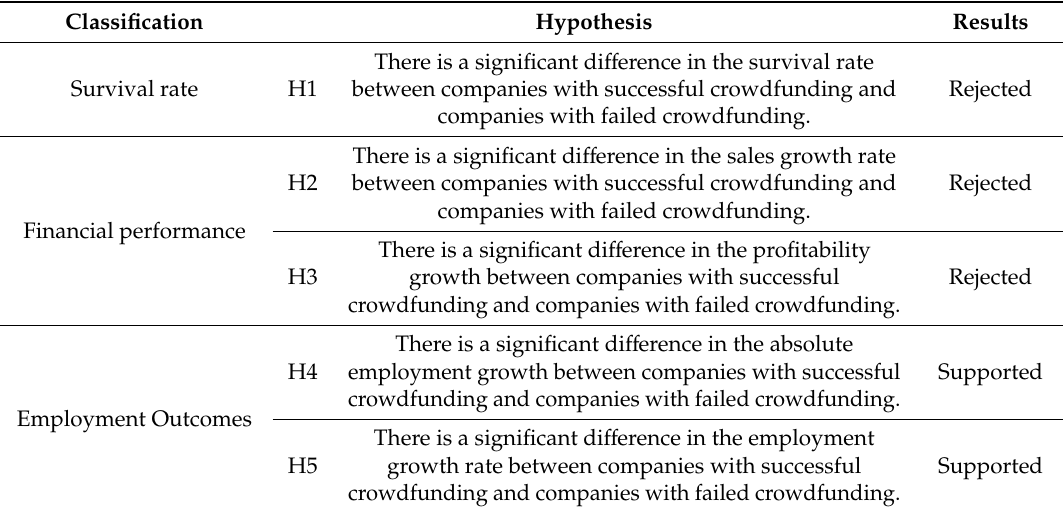
Table 11. Summary of results from hypothesis